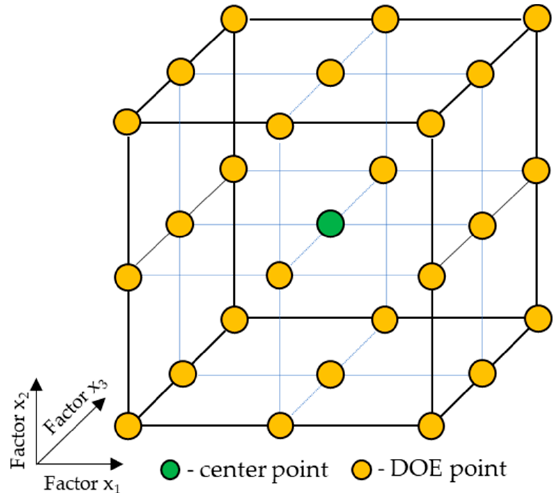
Figure 4. Graphical view for the three-level full factorial array (3 3 ).